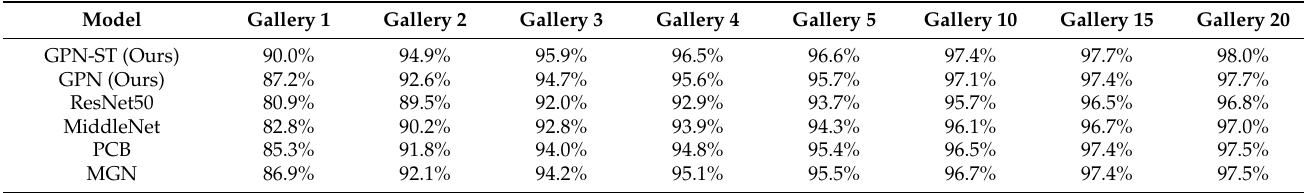
Table 2. Rank-1 accuracy of different models in different gallery sets